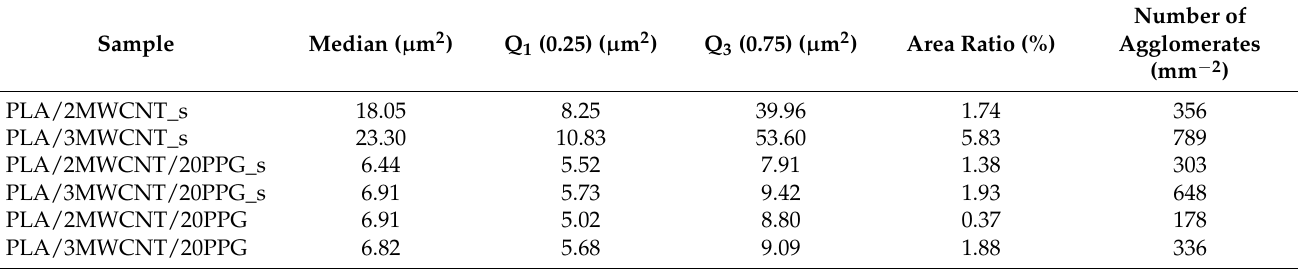
Table 3. Quartiles (Median, Q 1 , and Q 3 ) of the areas measured per sample, area ratio, and count of agglomerates per mm 2 .